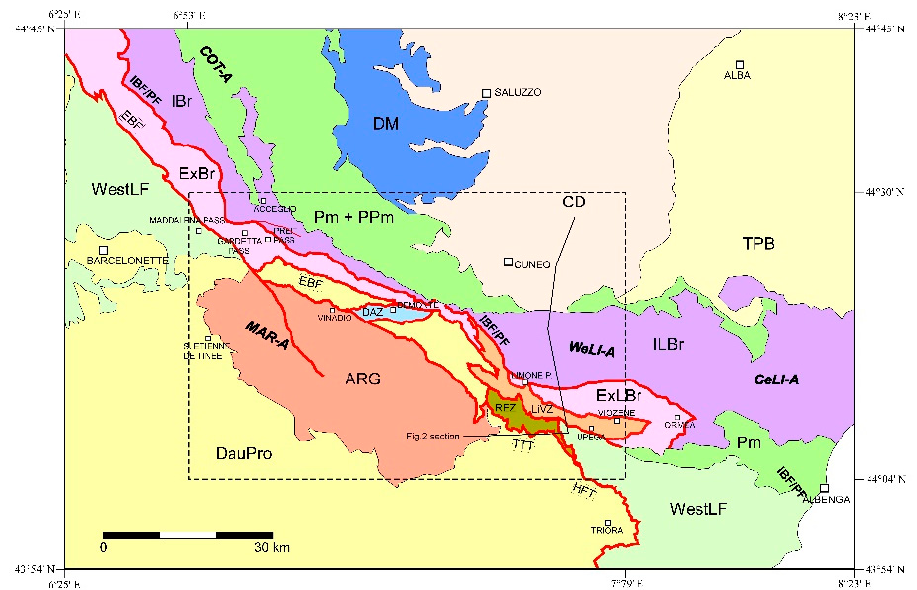
Figure 1. Geological sketch of the southern termination of the Western Alps. The main tectonic domains are represented with different colours. The black dashed rectangle corresponds to the study area of Figure 3. Legend: ARG: Argentera Massif; EBr: External Briançonnais Domain; IBr: Internal Briançonnais Domain; Pm: Piemonte Domain; PPm: Pre-Piemonte Domain; DM: Dora-Maira Domain; DauPro: Dauphinois—Provençal Domain; ExLBr: External Ligurian Briançonnais Domain; ILBr: Internal Ligurian Briançonnais Domain; TPB: Pliocene sediments and Tertiary Piemonte Basin; WestLF: Western Ligurian Flysch Domain; EBF: External Briançonnais Front; IBF/PF: Internal Briançonnais Front/Penninic Front; LiVZ: Limone-Viozene Zone; DAZ: Demonte-Aisone Zone; REZ: Refrey Zone; HFT: Helminthoides Flysch Basal Thrust; TTT: Tenda-tunnel Thrust; COT-A: Cottian Alps; MAR-A: Maritime Alps; WeLI-A: Western Ligurian Alps; CeLi-A: Central Ligurian Alps. The black line within the dashed inset refers to trace of the section of Figure 2. Adapted with permission from ref. [23]. Copyright 2016 Springer-Verlag Berlin Heidelberg.